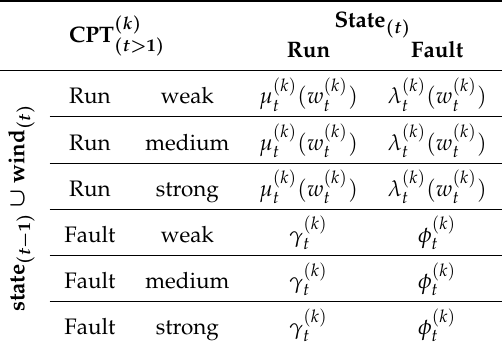
Table 3. CPT for t >